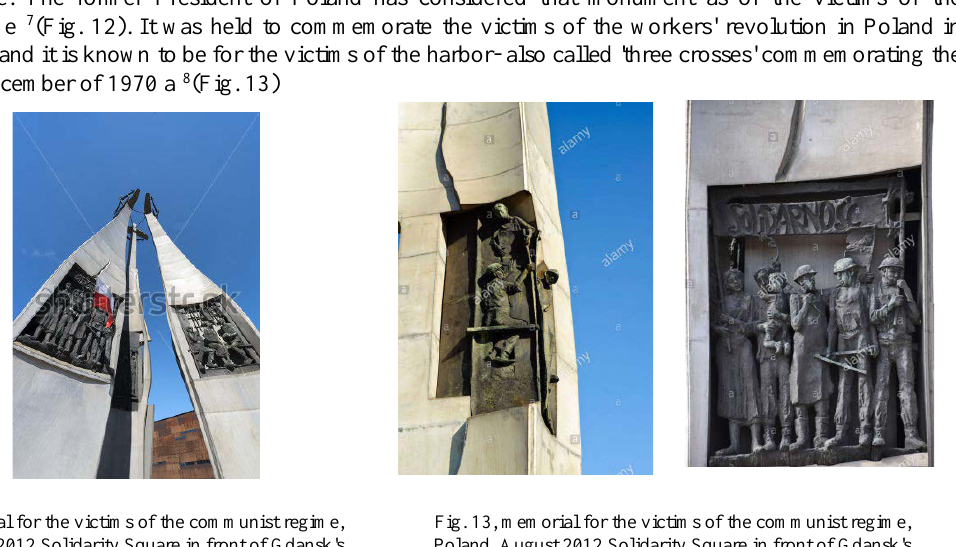
Fig. 12, memorial for the victims of the communist regime, Poland, August 2012 Solidarity Square in front of Gdansk's Shipyard. Former President of Poland